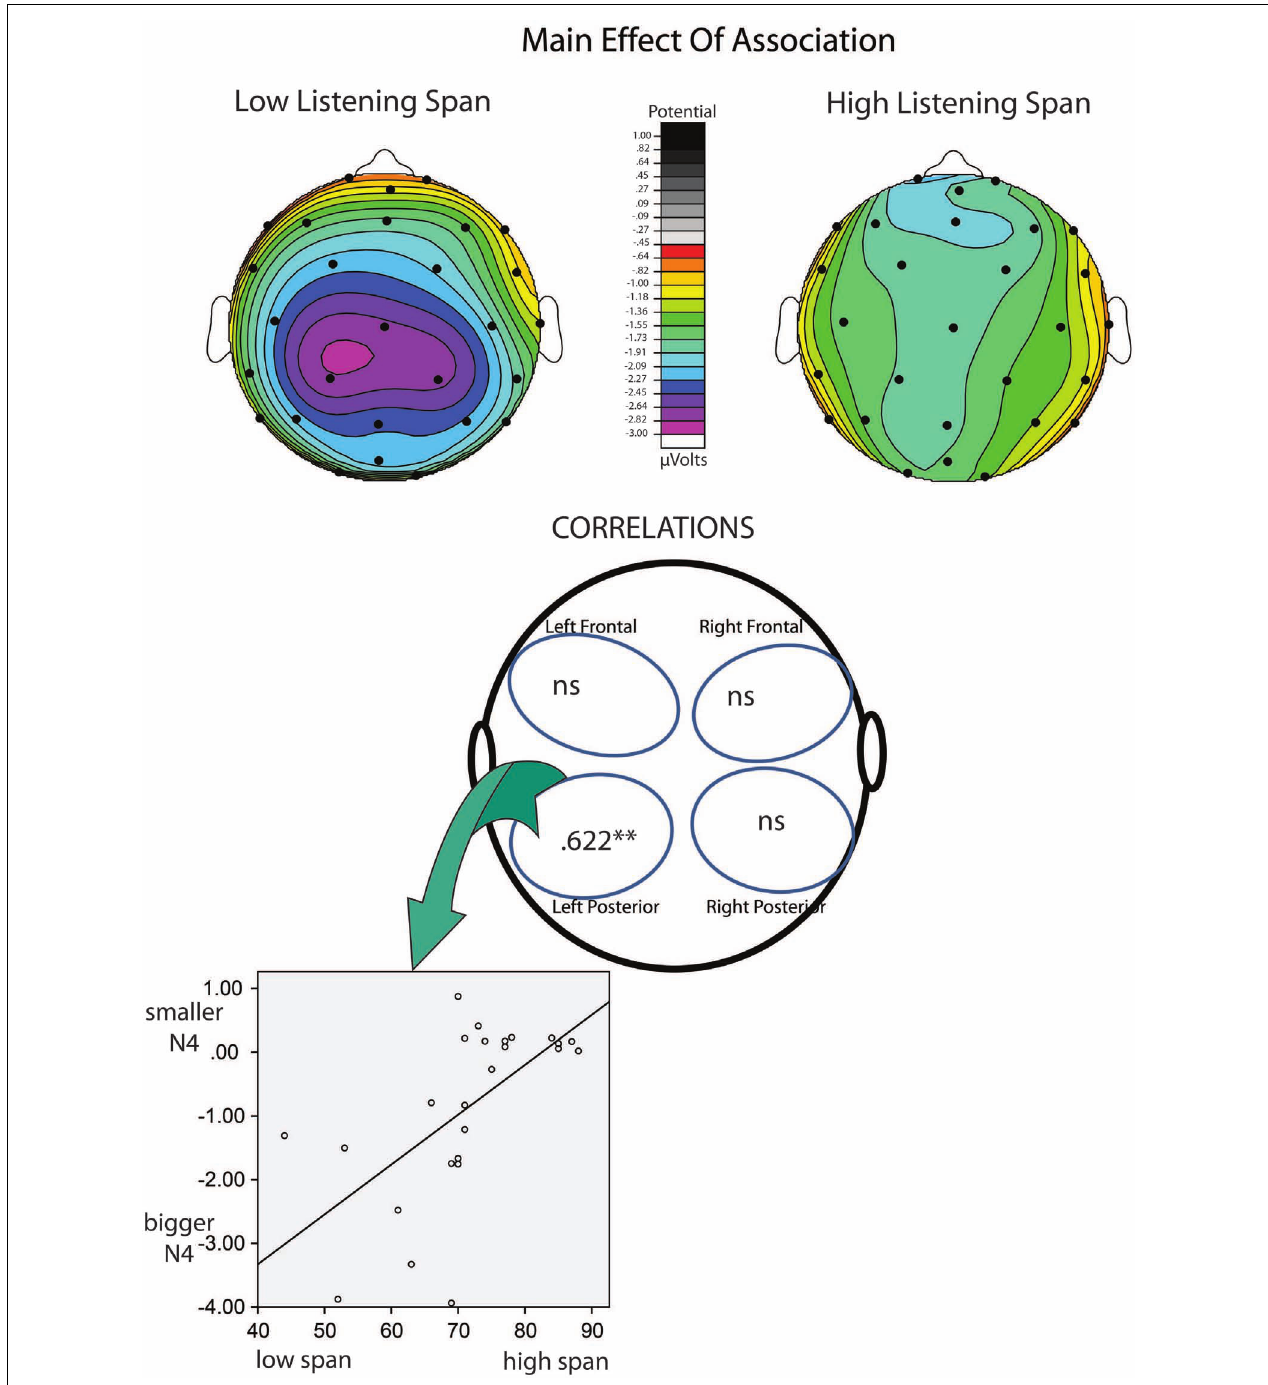
(left) and Low-Span participants (right). Correlations are shown at bottom. It is important to note that larger N400 effects are reflected by more negative